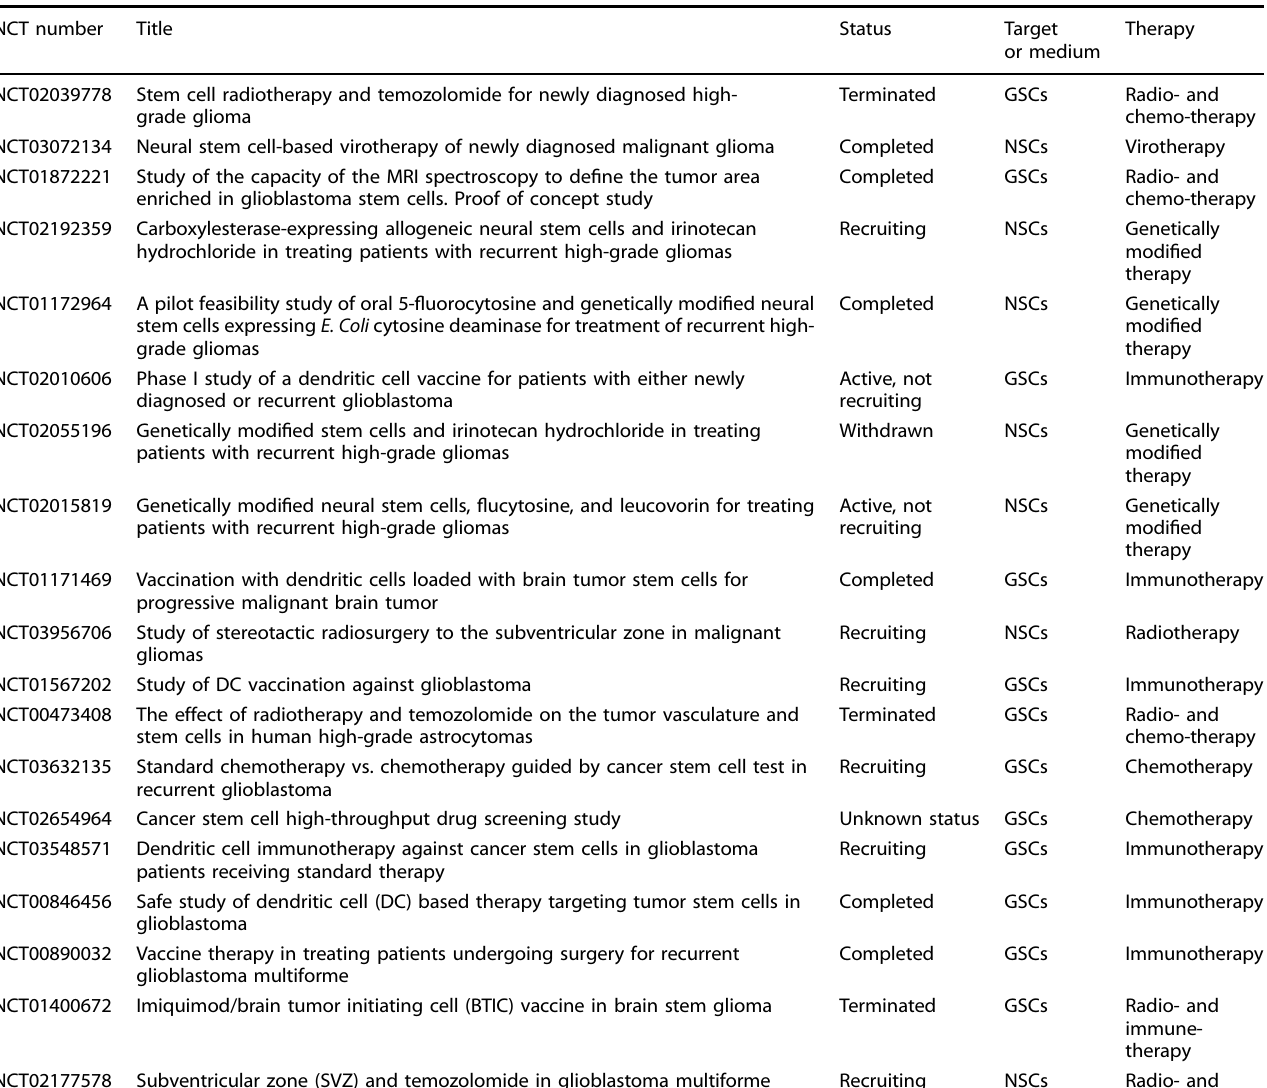
Table 4. Clinical trials target on GSCs or adopt NSCs as therapeutic